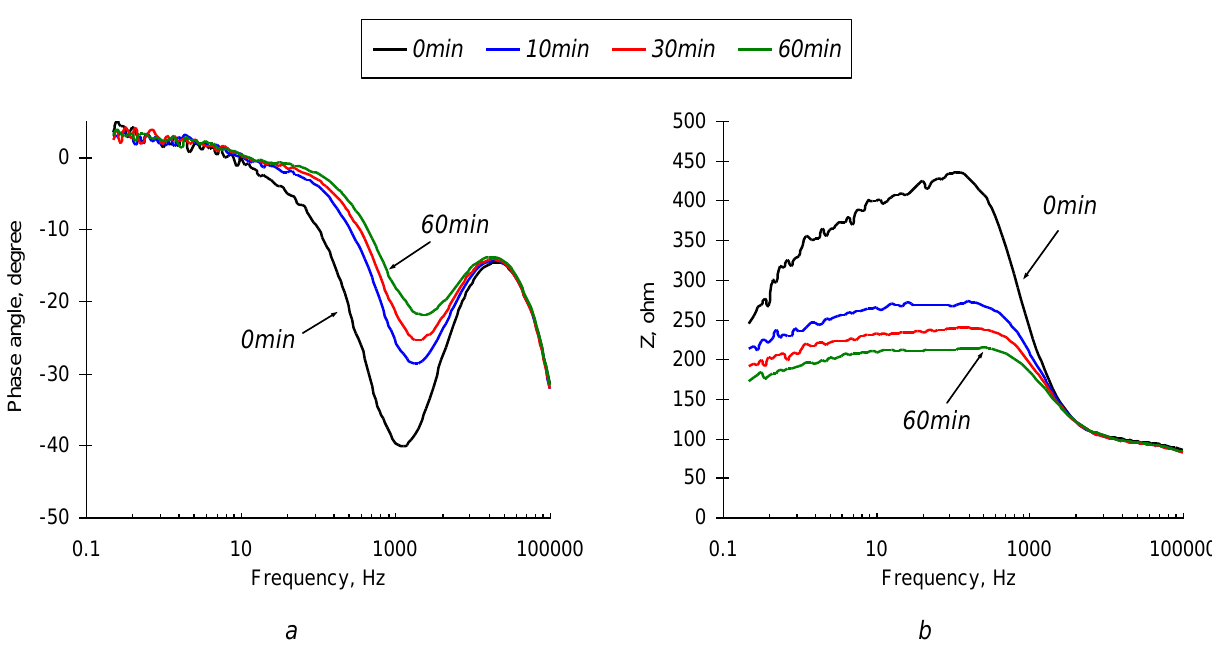
Figure 5. Phase angle and impedance spectrum of polarized (Δ φ = +0.1 V vs. Ag/AgCl) SEB immunosensor in 10 μg/mL of SEB in 0.3% NaCl